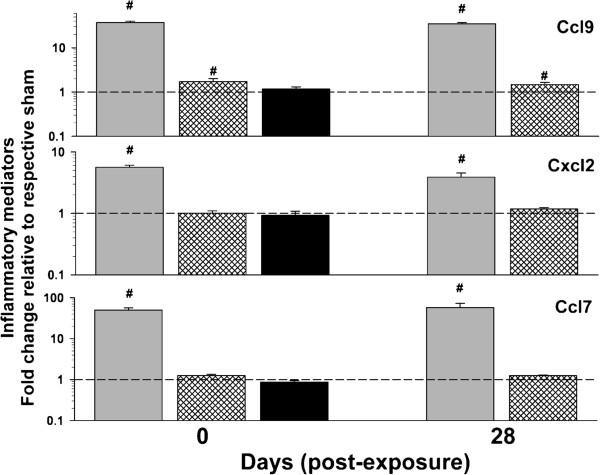
Effect of multi-walled carbon nanotube (MWCNT) inhalation on pulmonary inflammatory protein levels at different time points after exposure. Chemokine (C-X-C motif) ligand 2 (Cxcl2), chemokine (C-C motif) ligand 7 (Ccl7), and chemokine (C-C motif) ligand 9 (Ccl9) were measured from the first fraction of collected bronchoalveolar lavage fluid. Data are expressed as percent (%) change from respective sham (dashed line – 100%). Measurements were made from all doses at 0 d and the high and middle dose at 28 d since no effect was observed in the low dose at 0 d. Data presented as high dose (gray bars), medium dose (pattern), and low dose (black bars). *p<0.05 vs. respective sham; #p<0.05 vs. other MWCNT depositions for a given time point only.